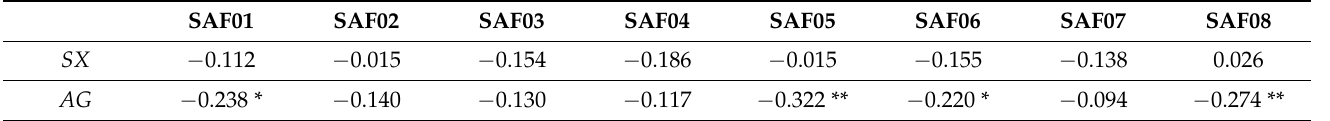
Table A11. Spearman correlation matrix: use of tools associated with